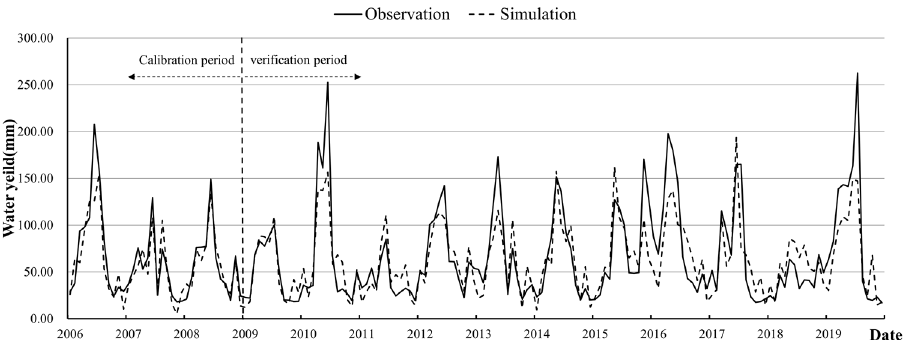
Figure 4. Simulation results for monthly water yield in the XRB (2006–2020).